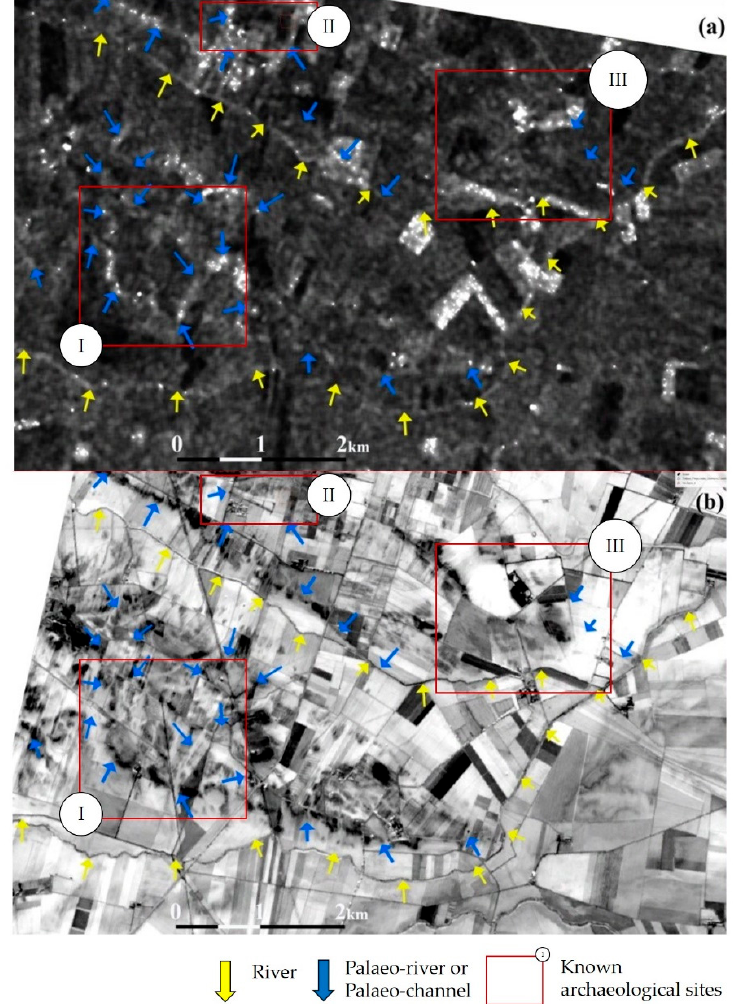
Figure 8. A palaeo-landscape including palaeo-rivers and palaeo-channels observed from: ( a ) VV S-1 data acquired on the 19 October 2019; ( b ) S-2 based soil map acquired on the 20 October 2019. The blue and yellow arrows indicate the palaeo-hydrographic and hydrographic features, observed from S-1 and S-2, respectively. The red numbered boxes indicate archaeological sites already known from bibliography and ancillary data, which are connected to a network of water-courses and roads: I. Località Ciamponetto (Neolithic and Roman settlements); II. Masseria Motticella (Neolithic settlement); III. Località Motta della Regina (neolithic settlement and medieval buildings) [66].